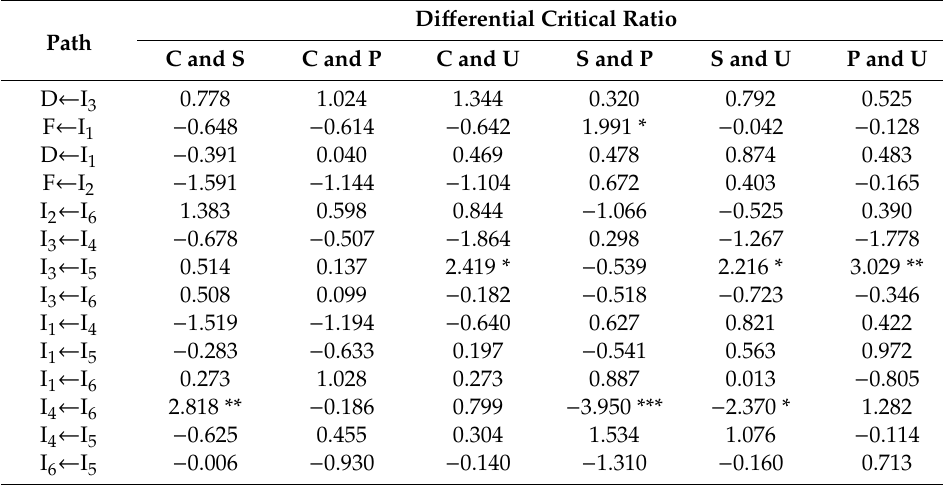
Table A5. Di ff erential critical ratio of paths between groups.